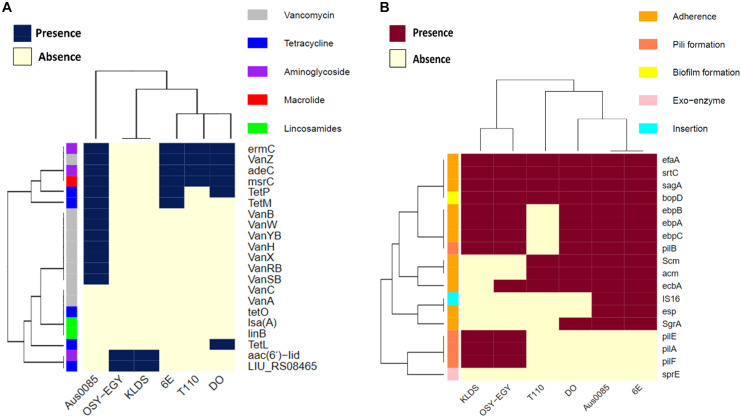
Heatmap showing the clustering of the compared Enterococcus spp. genomes based on the presence of (A) antibiotic resistance genes, and (B) virulence genes.